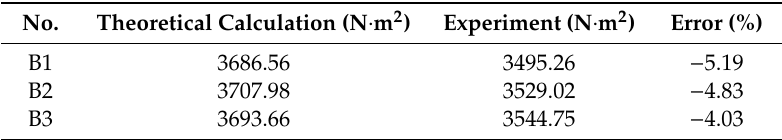
Table 6. The theoretical and experimental bending stiffnesses of composite sandwich laminated box beams.